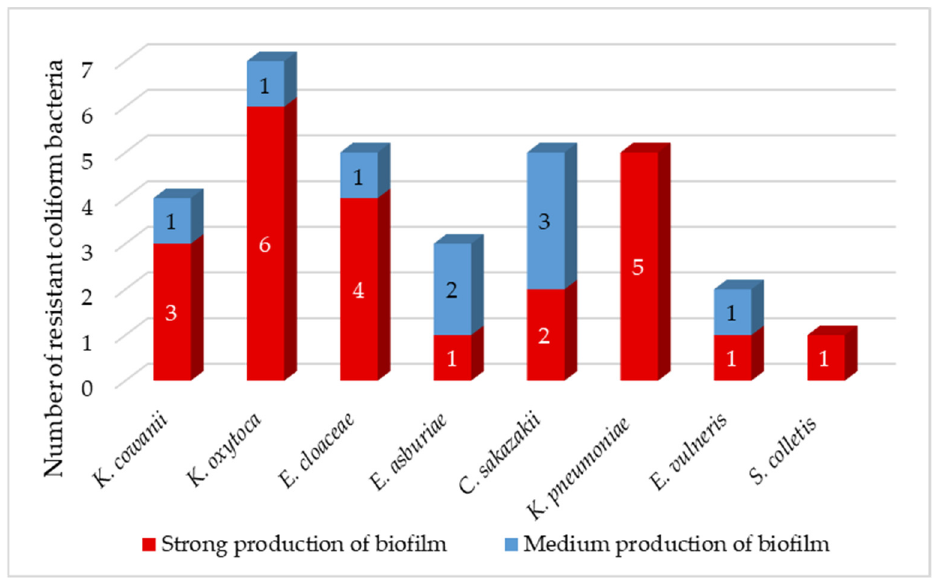
Figure 3. Production of biofilm between isolated resistant coliform bacteria. Foods 2022 , 11 , x FOR PEER REVIEW